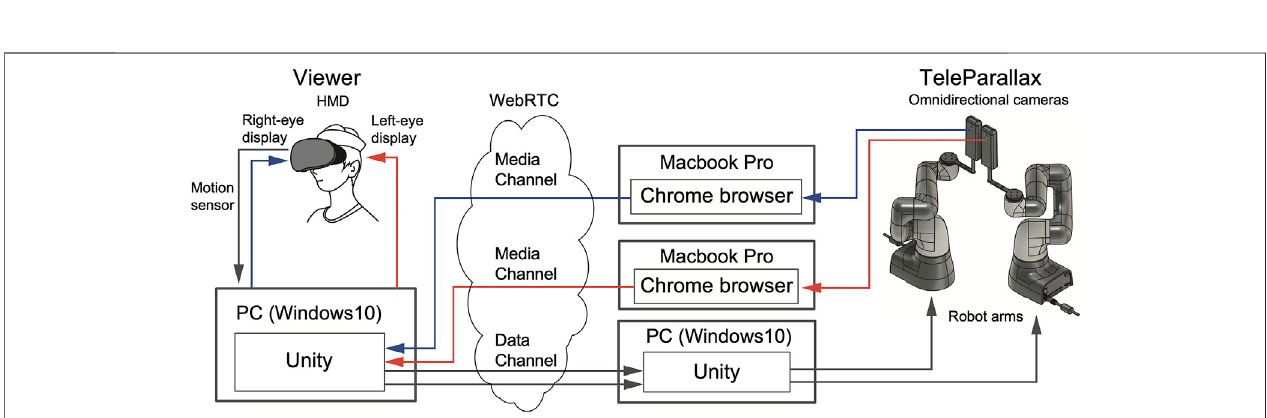
FIGURE 4 | System con fi